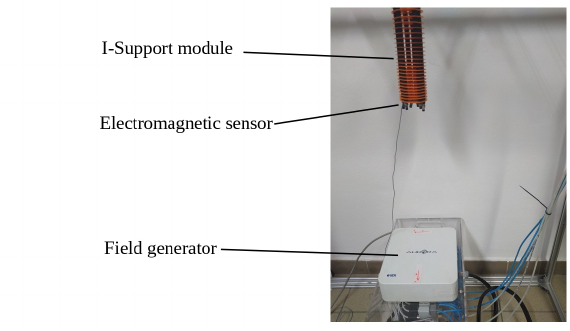
Figure 9. Experimental